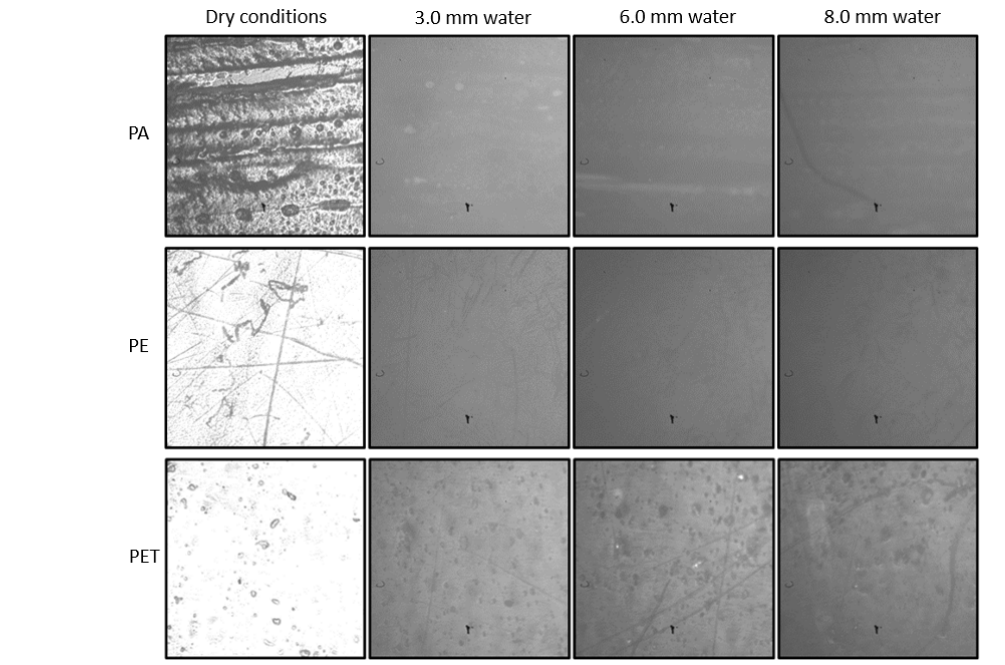
Figure 5. Images of the polymers PA, PE and PET in dry conditions and at 3.0, 6.0 and 8.0mm water